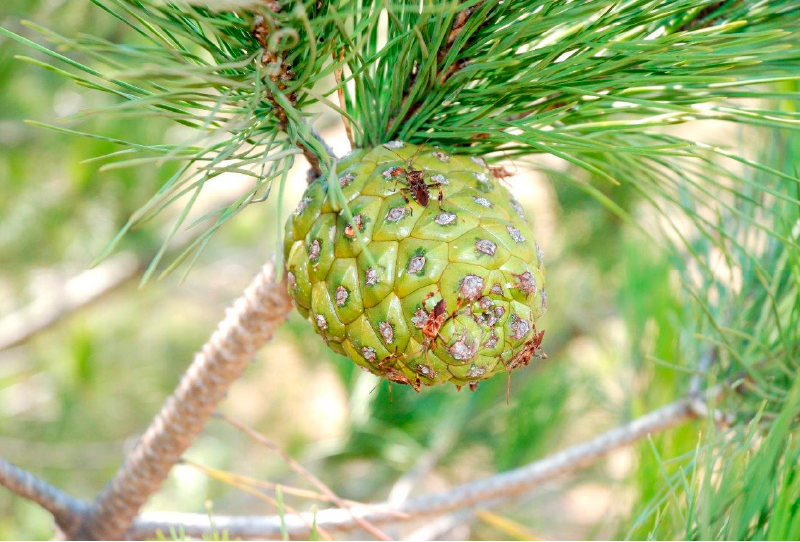
Figure 4. Several Leptoglossus occidentalis adults feeding at the expense of a three-year stone pine